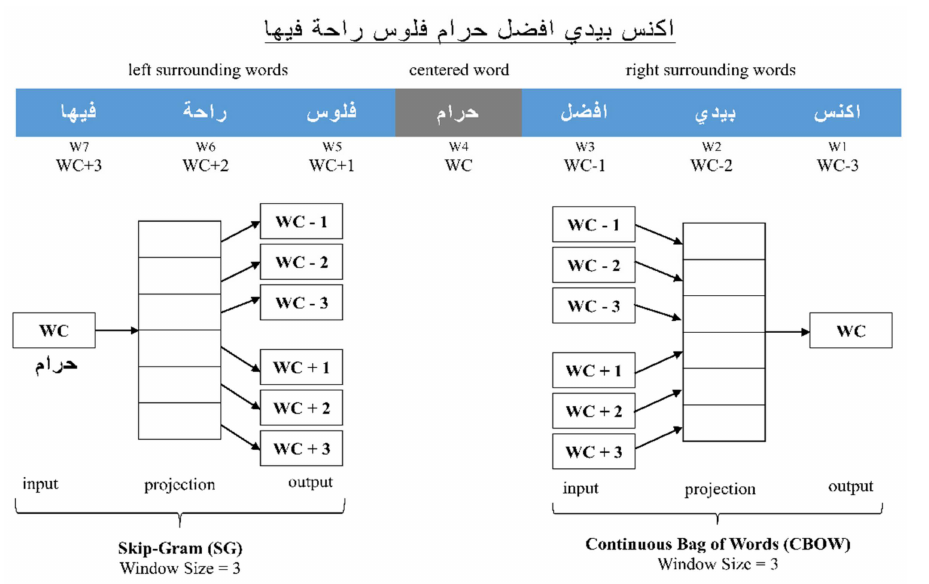
(cid:10)(cid:9) (cid:16) (cid:9) (cid:9) (cid:9) (cid:9) (cid:65)(cid:238)(cid:68) (cid:175) (cid:233)(cid:107)(cid:64)(cid:80) (cid:128)(cid:241)(cid:202) (cid:175) (cid:208)(cid:64)(cid:81)(cid:107) (cid:201) (cid:146) (cid:175)(cid:64) (cid:248) (cid:89)(cid:74)(cid:10)(cid:75)(cid:46) (cid:129) (cid:28)(cid:187)(cid:64) (cid:10) ’